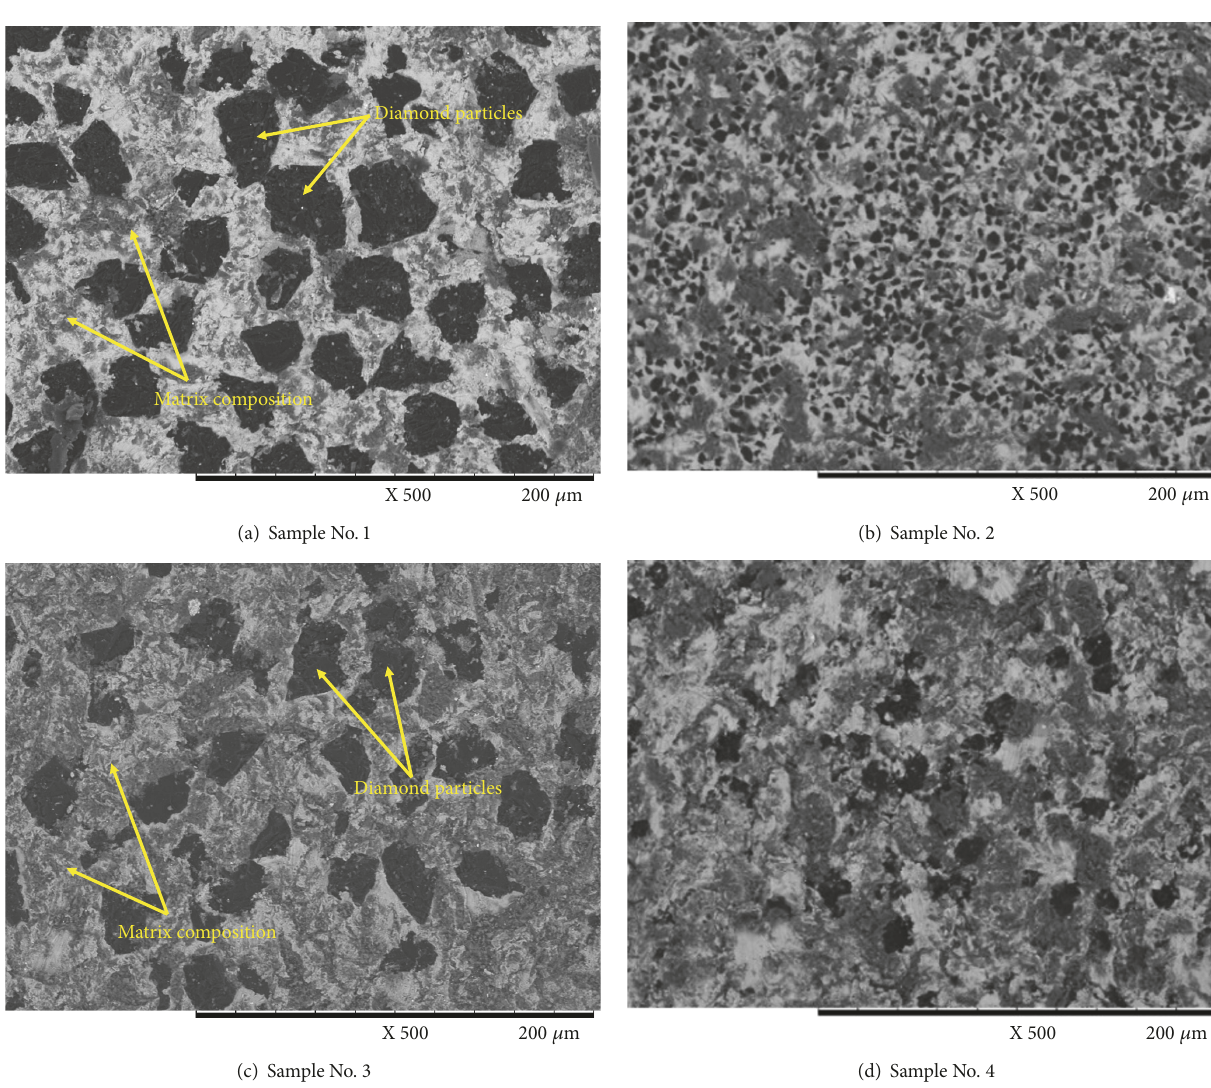
Figure 5: SEM micrograph of samples 1-4 after SPSing and cleaning by alumina particles